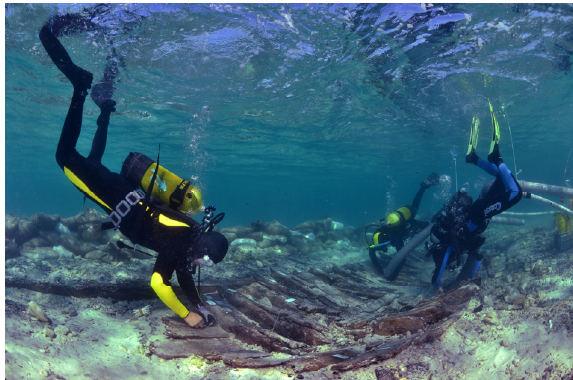
Figure 11. Underwater excavation and documentation of the hull (foto G. Piccioli).